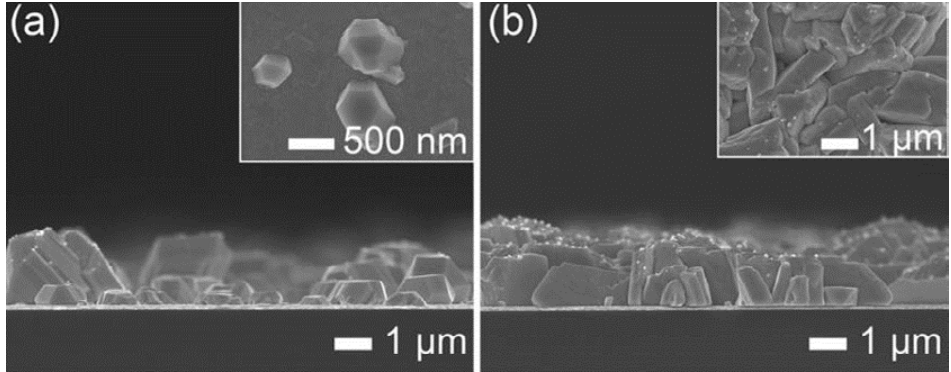
Fig. 5: Typical SEM images of Ag deposits with AgNO deposited in the electrolytes of (a) 0.2 and (b) 2 mM AgNO (The insets denote the top-view SEM images). Reproduced with permission from ref. 34, copyright 2013,